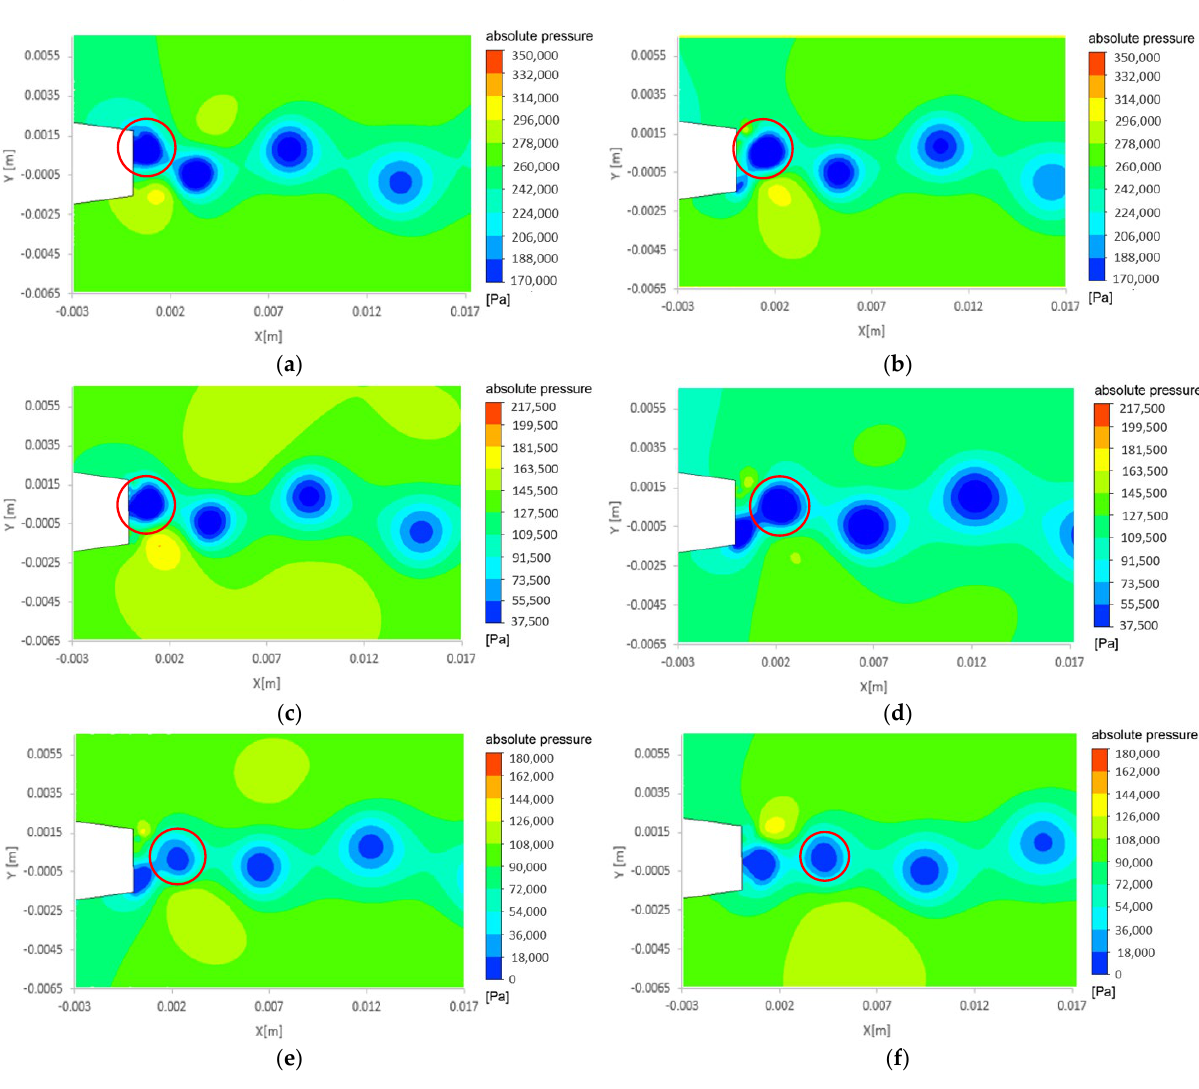
Figure 12. Absolute pressure for σ ( b , d , f ). t / T = 0.25 ( b , d , f